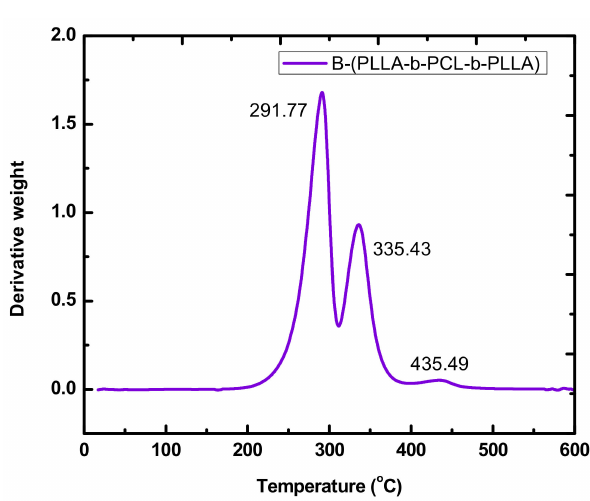
Figure 15. DTG plot of the sample BDBC.